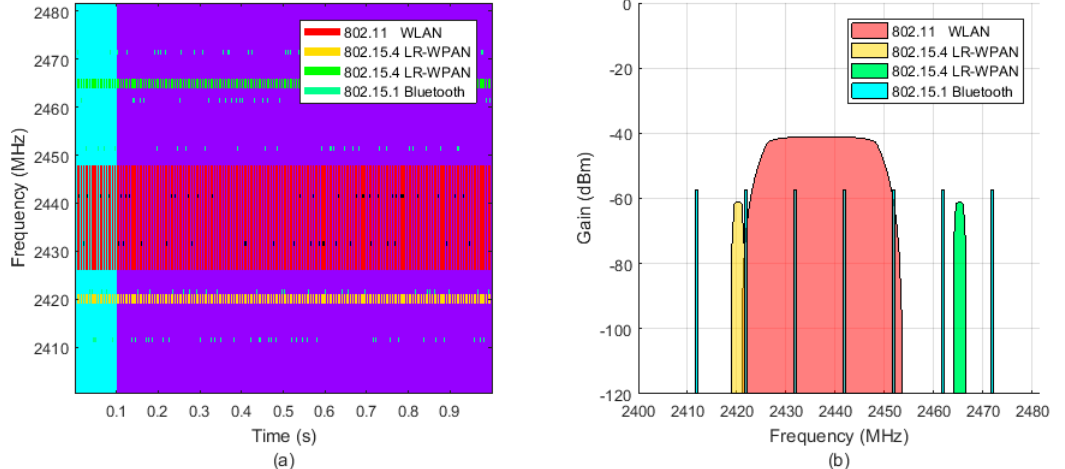
Figure 18. Interference noise at the gateway location: ( a ) Frequency pattern. The WLAN network transmits in the 6th channel of the 802.11 standard, centred at 2437 MHz with a bandwidth of 22 MHz (red). The LR-WPAN A network transmits in the 4th channel of the 802.15.4 standard, centred at 2420 MHz with a bandwidth of 3 MHz (yellow). The LR-WPAN B network transmits in the 13th channel, centred at 2465 MHz (green). The Bluetooth network transmits over seven frequency channels with a bandwidth of 1 MHz each, hopping from channel to channel in a random way (blue); ( b ) Signal strength. The signal strength of each interfering network at the gateway position is calculated according to the free-space path loss model. The four interfering networks are at the same distance from the gateway, but have different signal strengths as they have different transmission powers.